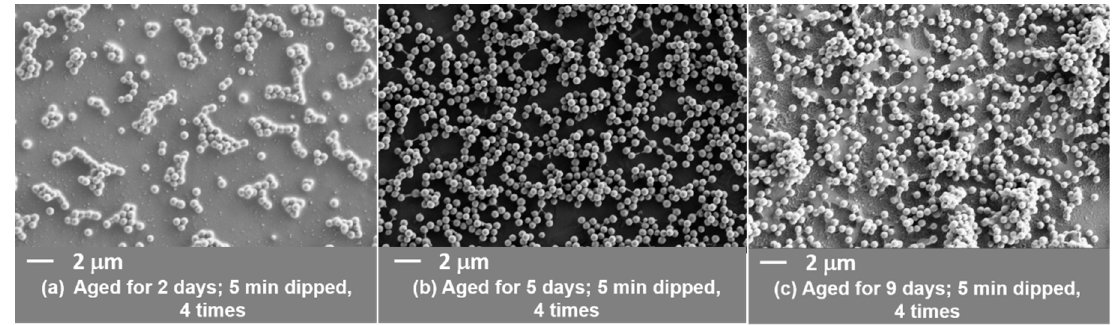
Figure 5. SEM images of hydrophobic silica coatings dipped for 5 min four times and aged for ( a ) 2 days, ( b ) 5 days and ( c ) 9 days.